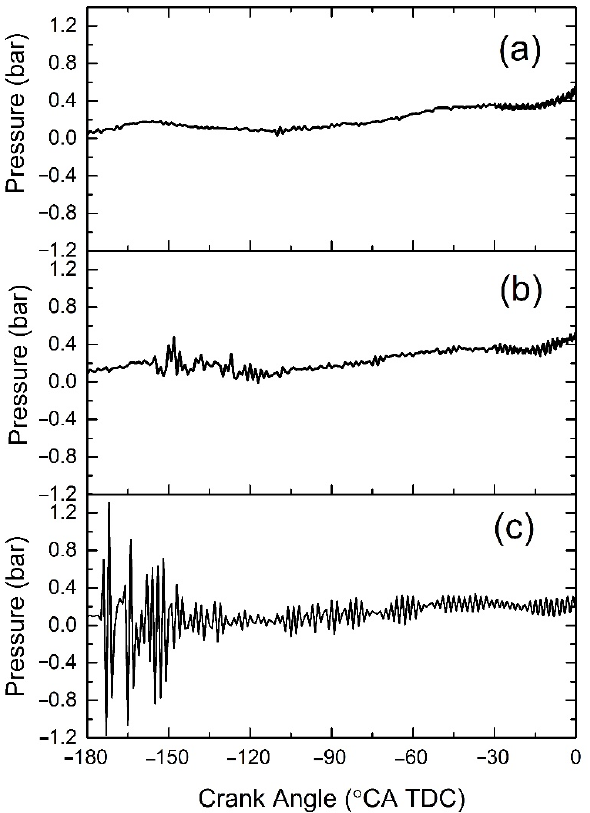
Figure 15. The different types of exhaust pressure fluctuations: ( a ) pressure without fluctuation; ( b ) pressure with slight fluctuation; ( c ) pressure with severe fluctuation.